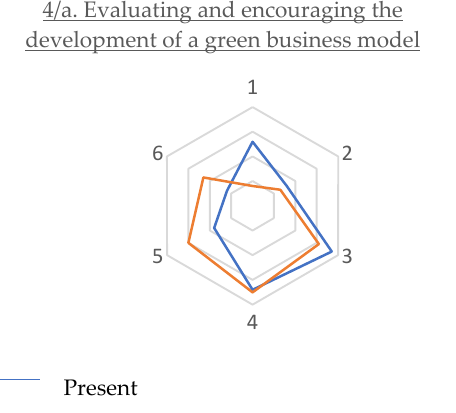
Figure 7. The spider web diagram of the scores given by the respondents at Stage 4 of becoming sustainable. Source: edited by authors.